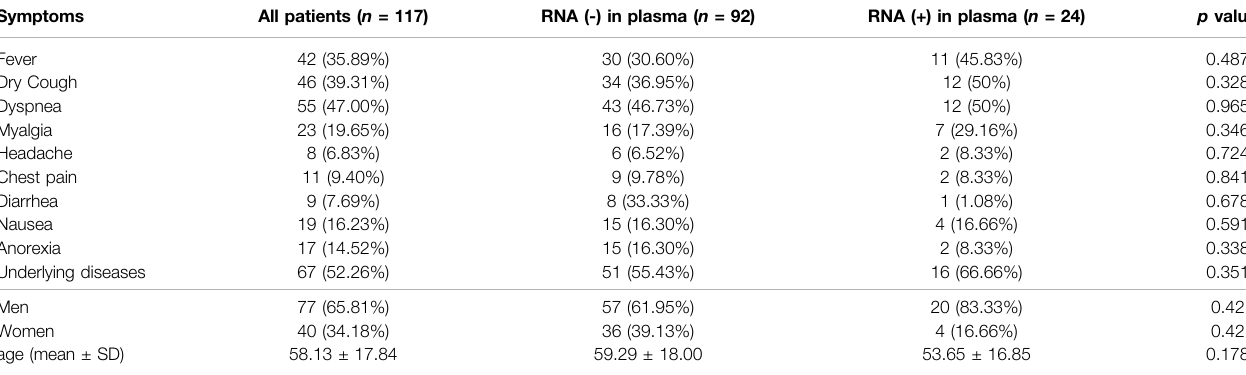
TABLE 2 | A comparison of demographic and clinical data of patients with SARS-CoV-2 RNA positive/negative results in plasma samples. Symptoms All patients ( n = 117) RNA (-) in plasma ( n = 92) RNA (+) in plasma ( n = 24) Fever